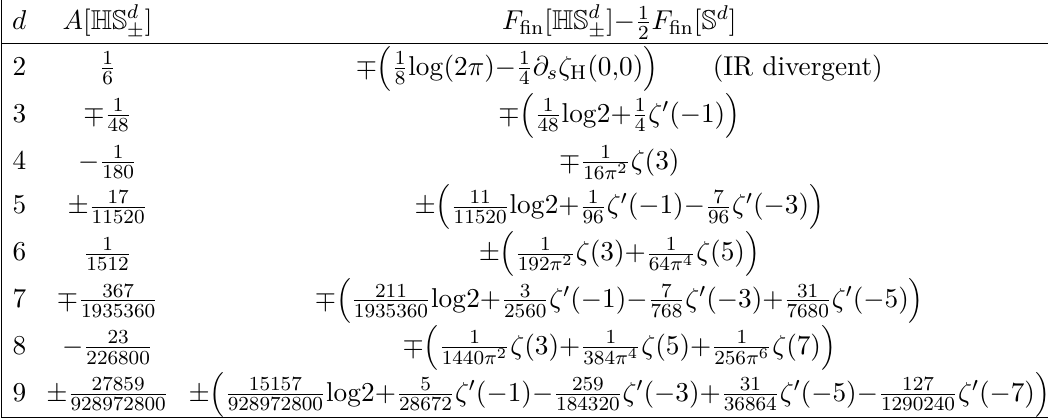
Table 4 . The anomaly and the finite parts of the free energies on HS d